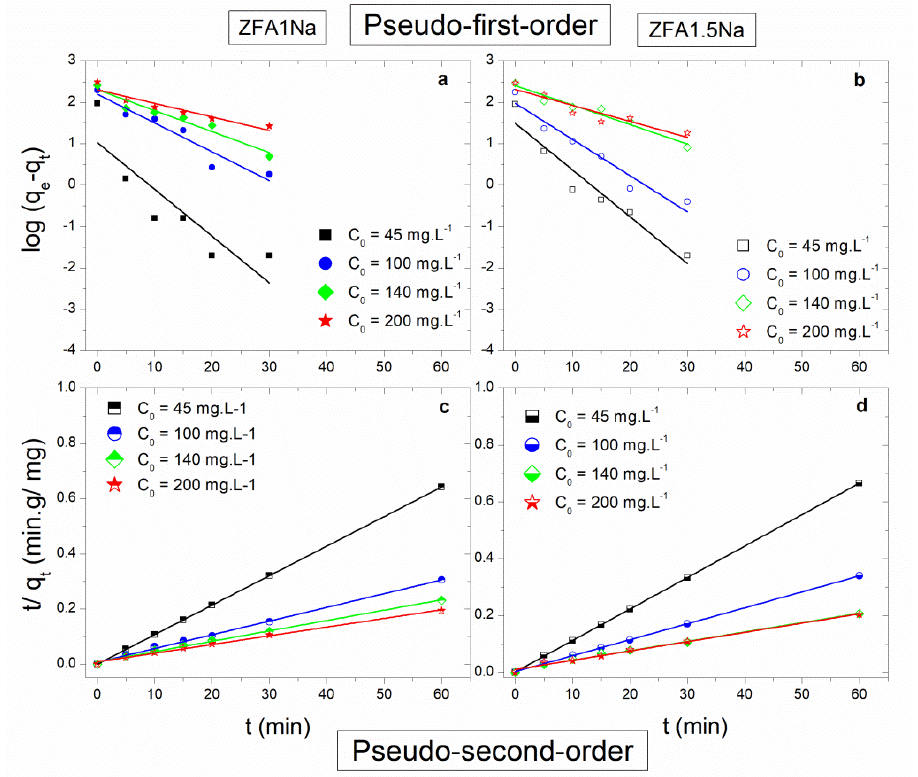
Figure 6. Pseudo-first-order ( a , b ) and pseudo-second-order ( c , d ) removal of Cu onto ZFA1Na and ZFA1.5Na zeolites (dosage 0.5 g · L − 1 , Cu concentration 45–200 mg L − 1